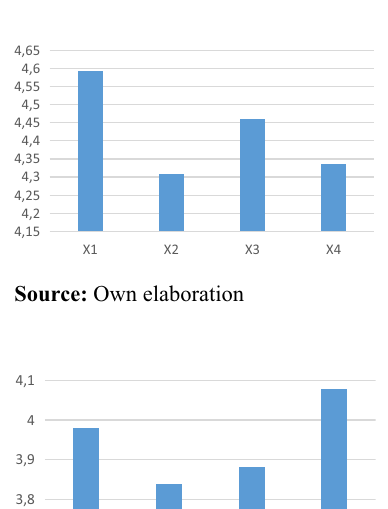
Figure 3. The average score of